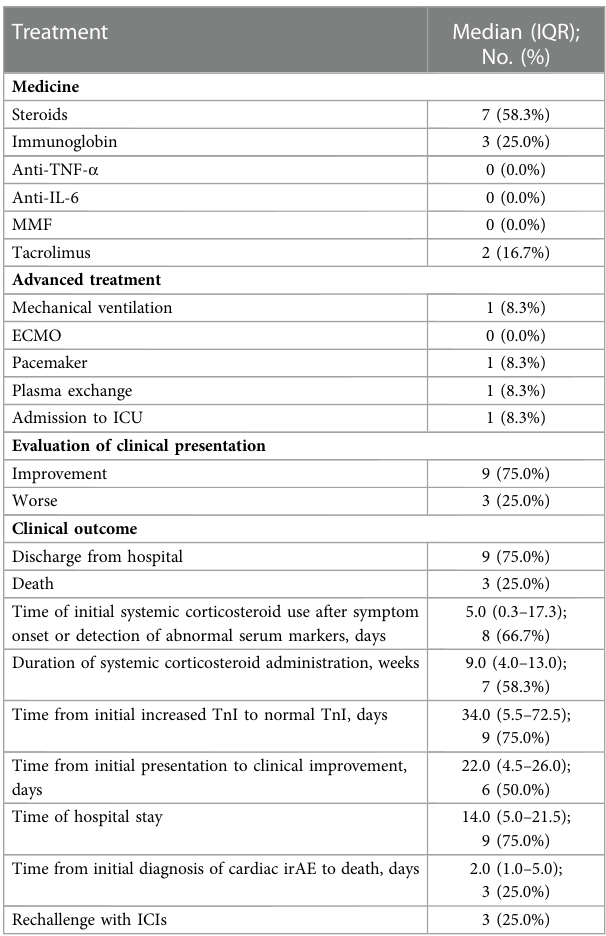
TABLE 5 The ef fi cacy with ICIs for patients with cardiac irAE. TABLE 4 Clinical treatment and outcome for patients with cardiac irAE.